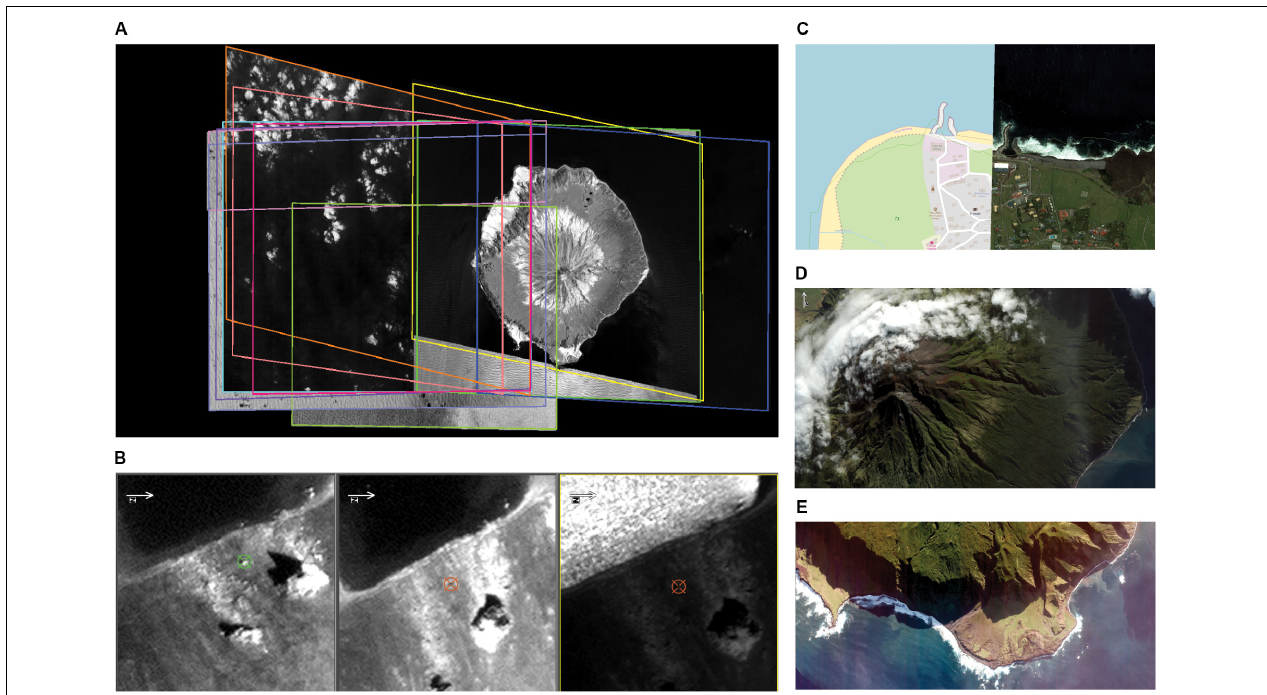
FIGURE 3 | (A) WorldView 2 image stack. (B) Geometric resolution and feature definition. (C) Lack of co-registration between QB and OSM. (D) WorldView3 Scene showing clouds and haze. (E) WorldView3 scene showing shadow and